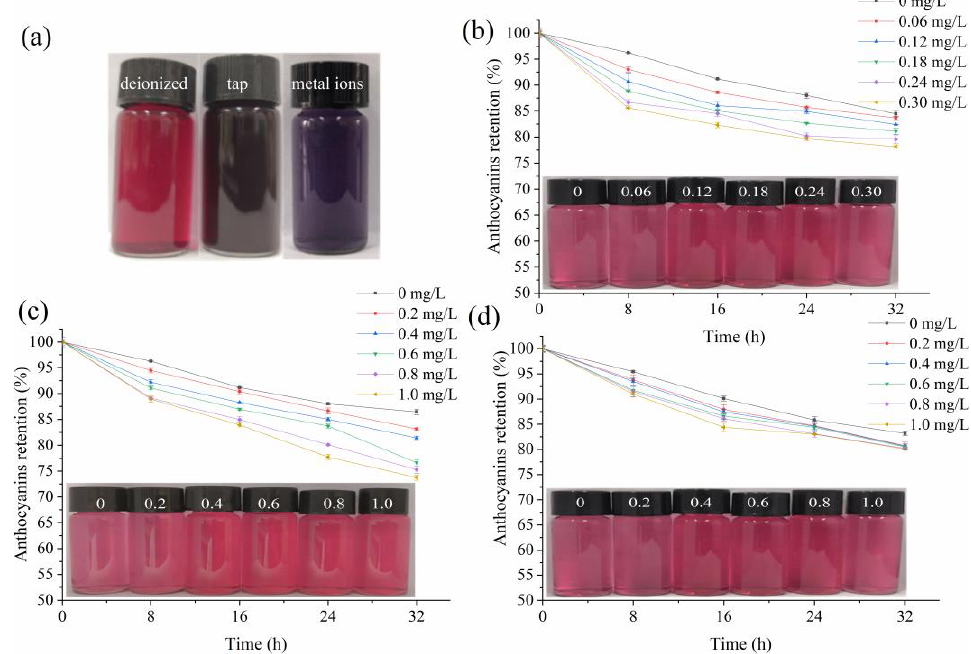
Figure 1. Appearances of the 0.02% ( w/v ) BRA solutions dissolved in deionized water (left), tap water (middle), and deionized water containing the nine metallic ions allowed by GB 5749-2006 ( a ) as well as the color stability of BRA against different concentrations of Fe 3+ ( b ), Cu 2+ ( c ), and Fe 2+ ( d ). The insets are the appearances of the fresh BRA solutions containing the corresponding metals in concentrations from low to high.